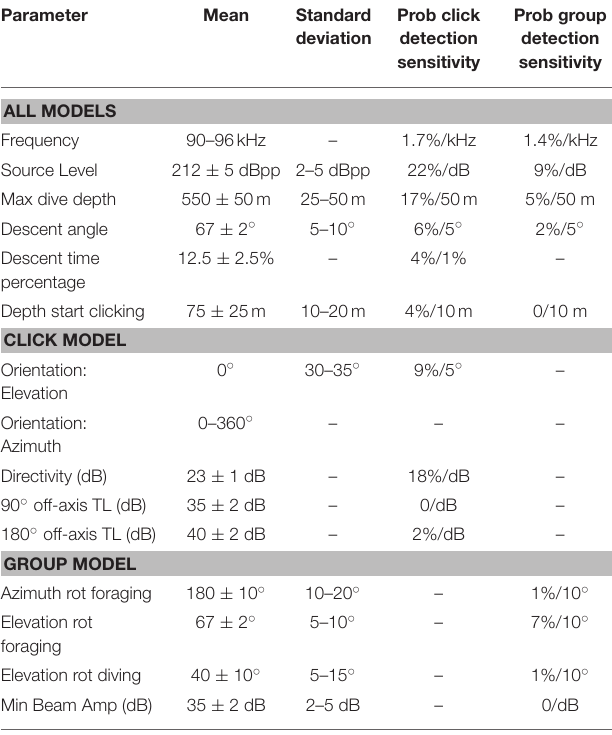
TABLE 3 | Monte Carlo simulation parameters used to model probability of detecting individual clicks and groups of clicking animals, along with their modeled